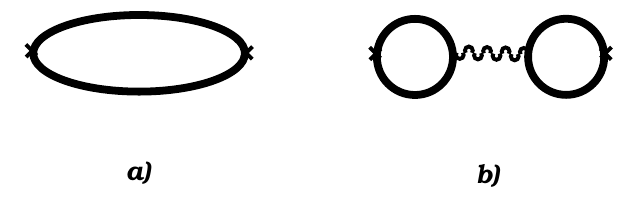
Figure 2 . Diagrams contributing to the correlator h T ( z ) T (0) i in the mean-(cid:12)eld approximation. The